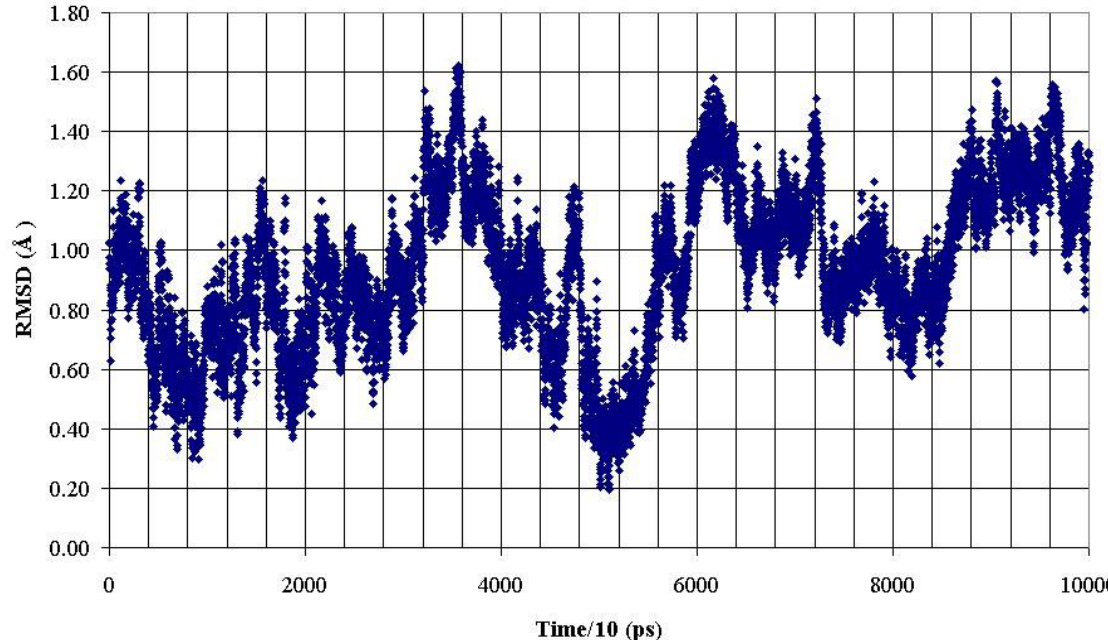
Figure 8. RMSD of backbone heavy atoms of the PDTRP fragment of the glycosylated peptide AHG21 (T17) during 1 ns MD simulation within reference at the crystal structure